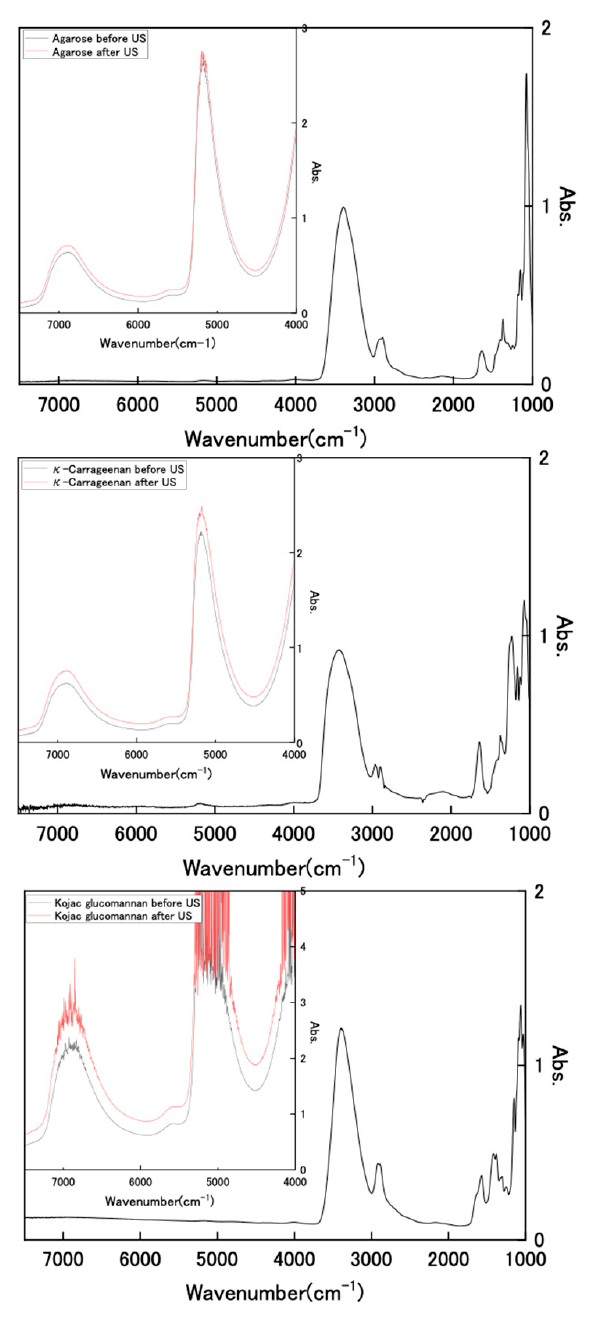
Figure 4. FT-IR and near-IR spectra of dried polysaccharides and wet state hydrogels with and without US